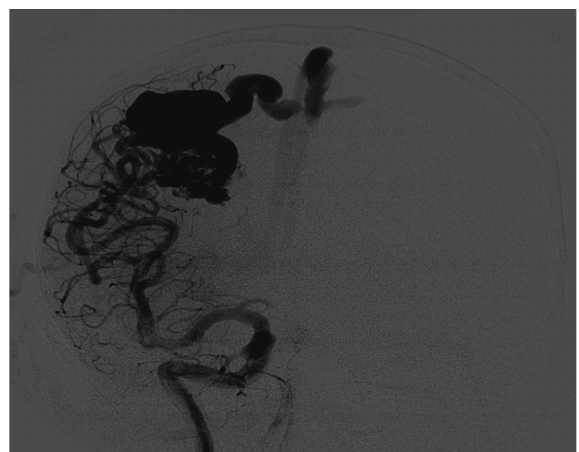
Figure 1: AP and lateral projections of angiogram of right selective internal carotid artery injection showing the arteriovenous malformationin this late arterial phase, with filling of a large venous channel into the superior sagittal